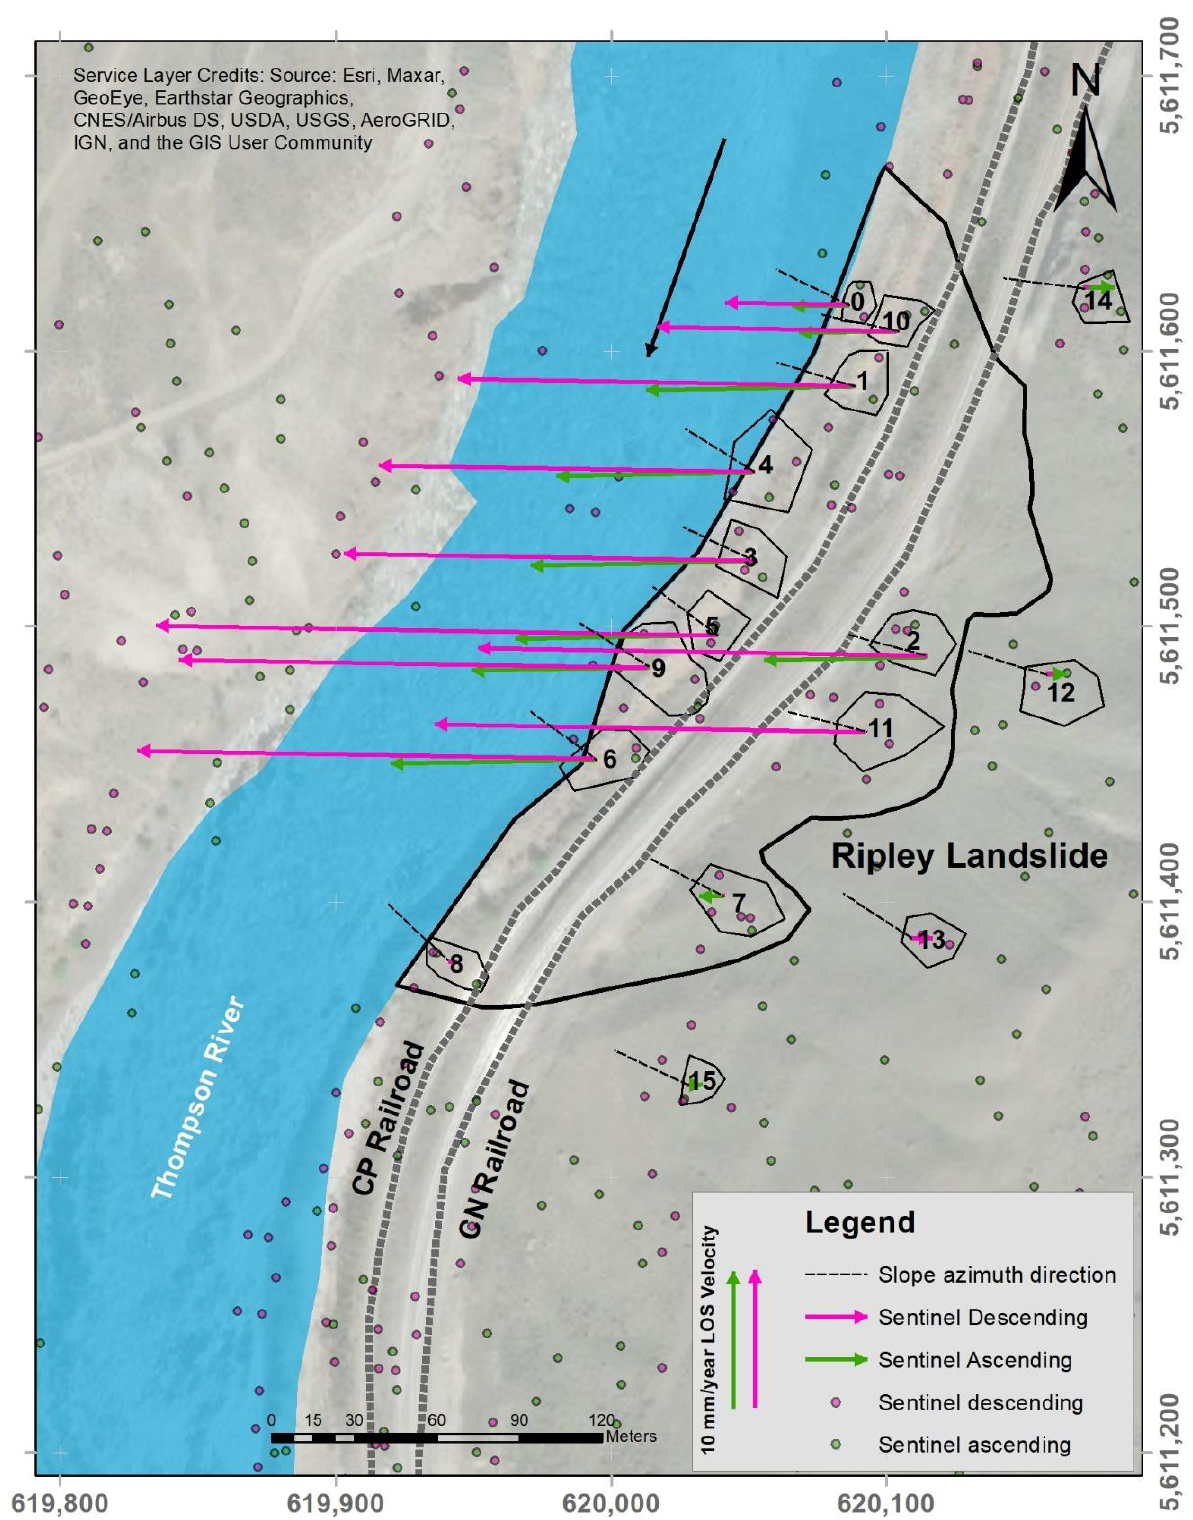
Figure 6. LOS vectors projected on the horizontal plane for both Sentinel ascending and Sentinel descending orbits. The average direction of the slope azimuth is also shown.